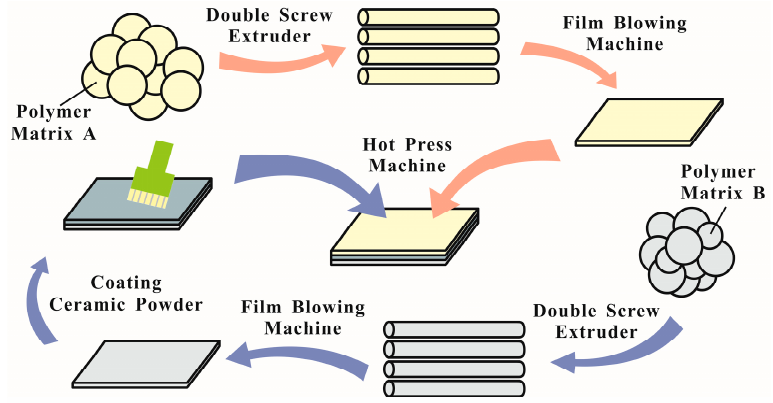
Figure 1. Detailed manufacture of sandwich-structured composites.